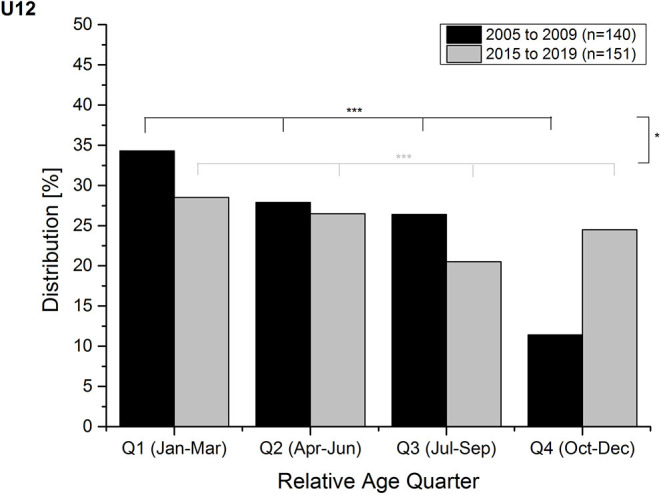
Changes in the relative age quarter distributions of former (black) to current (light gray) U12 youth ski racers. ***p < 0.001; *p < 0.05.